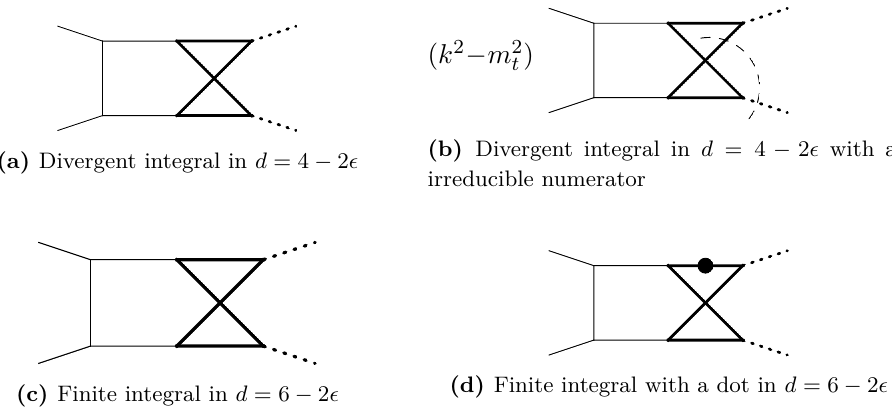
Figure 4. Examples of divergent and finite integrals in the limit (cid:15) → 0 for a non-planar topology. Thick solid lines represent the top-quark while thick dashed lines represent Z-bosons. Topology (b) contains an irreducible numerator, where k is the difference of the momenta of the edges marked by the thin dash